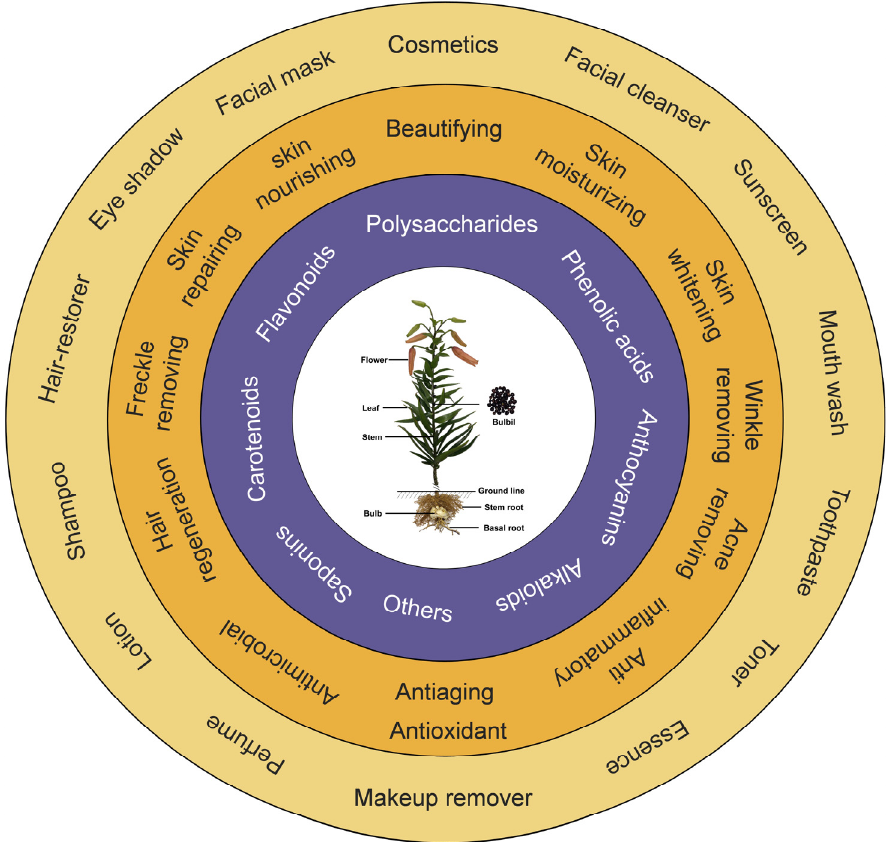
Figure 5. Metabolites, functions, and applications in cosmetics of Lilium .